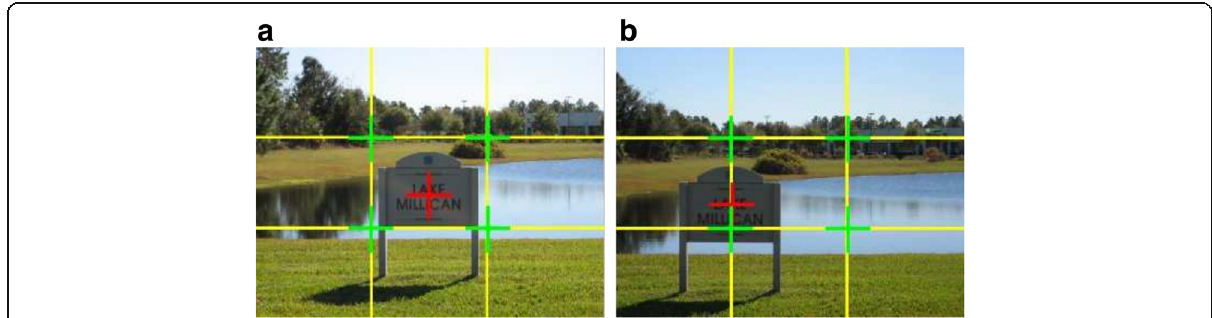
Fig. 3 An example of foreground in the middle ( a ) and ( b ) in the one third position